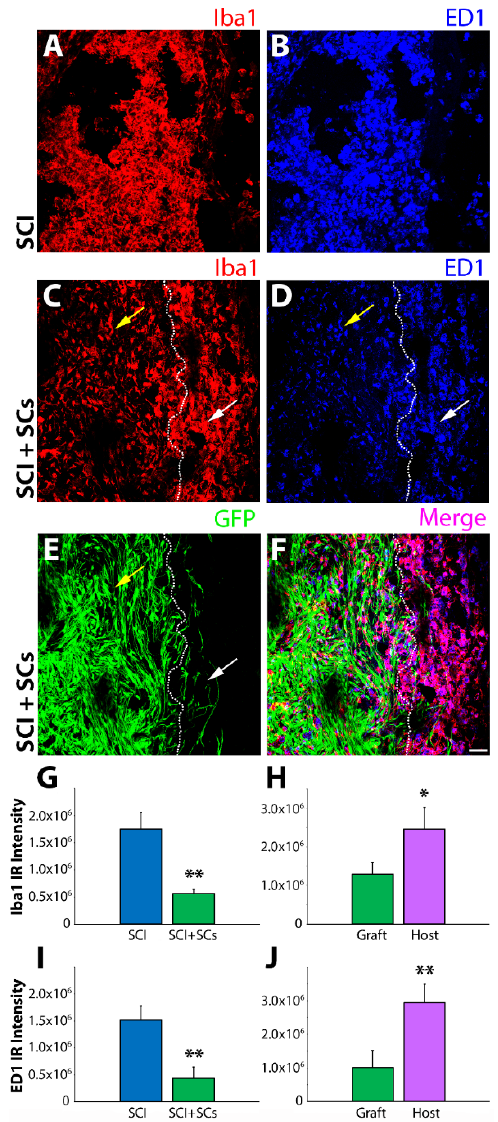
Figure 1. Immunoreactivity for ionized calcium-binding adapter molecule 1 (Iba1) and cluster of differentiation molecule 68 (CD68) was reduced within the lesion–Schwann cell (SC) implant of transplanted animals after spinal cord injury (SCI). Confocal micrographs of horizontal spinal cord sections from SCI control and SCI, enhanced green fluorescent protein (EGFP-SC)-transplanted animals ( n = 4) at 2 weeks post-injury (1 week post-transplantation) immunostained for Iba1 (red) and CD68 (blue). In SCI control tissue, there was significant infiltration of both Iba1 and CD68 immune cells within the lesion ( A , B ). In contrast, in EGFP-SC-transplanted animals, the numbers of Iba1 and CD68 immune cells was greatly attenuated within the lesion–SC implant ( C – F ). Quantification of fluorescent intensity showed that EGFP-SC transplantation led to reductions in both Iba1 ( G ) and CD68 ( I ) that were more pronounced within the lesion than in adjacent host tissue ( H , J ). Results expressed as mean ± standard error of the mean (SEM). Statistical significance indicated at * p < 0.05 and ** p < 0.01 compared with SCI controls. Images were acquired at 20 × objective magnification. Yellow arrows indicate the lesion-SC implant and white arrows the perilesional area. Scale bar = 50 μm.